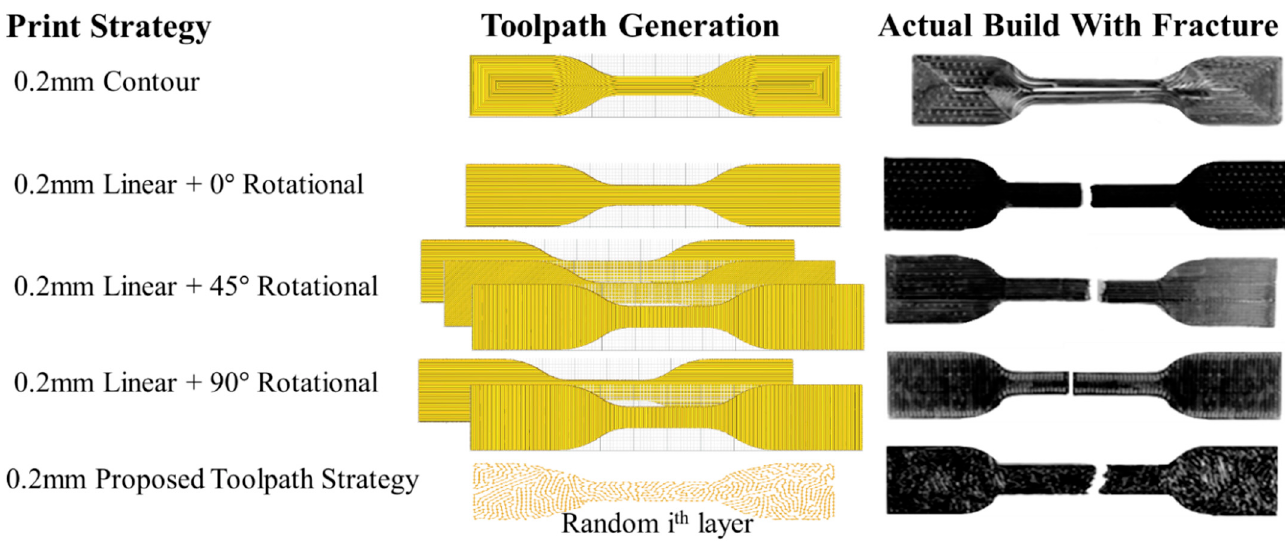
Figure 7. Fractured dogbone specimens at layer thickness =